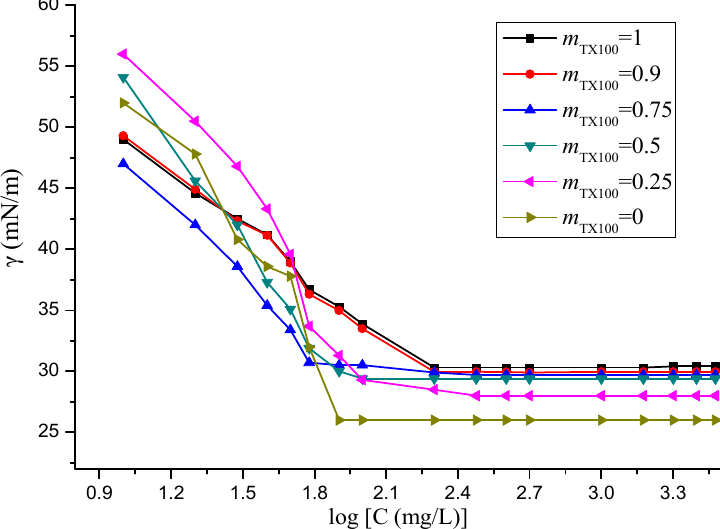
Figure 1. Plots of surface tension as a function of the logarithm values of the total surfactant concentration of the single and TX100–Rham mixture at 10, 20, 30, 40, 50, 60, 80, 100, 200, 300, 400, 500, 1000, 1500, 2000, 2500, 3000 mg / L and with mass ratios of TX100 and Rham at 1:0; 9:1; 3:1; 1:1; 1:3; and 0:1, respectively. ( γ : surface tension; C : total surfactant concentration; m TX100 : the bulk mass fraction of TX100 in TX100 and rhamnolipids (Rham) mixture).